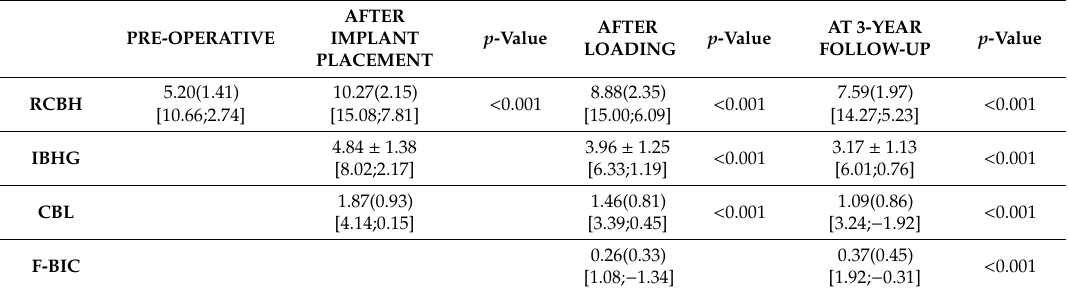
Table 3. RCBH (residual crestal bone height), IBHG (intra-sinus bone height gain), CBL (crestal bone level), and F-BIC (first bone-to-implant contact point). Values are presented as mean ± SD (max;min), or median(iqr) (max;min) at each time interval; SD = standard deviation; iqr = interquartile range.